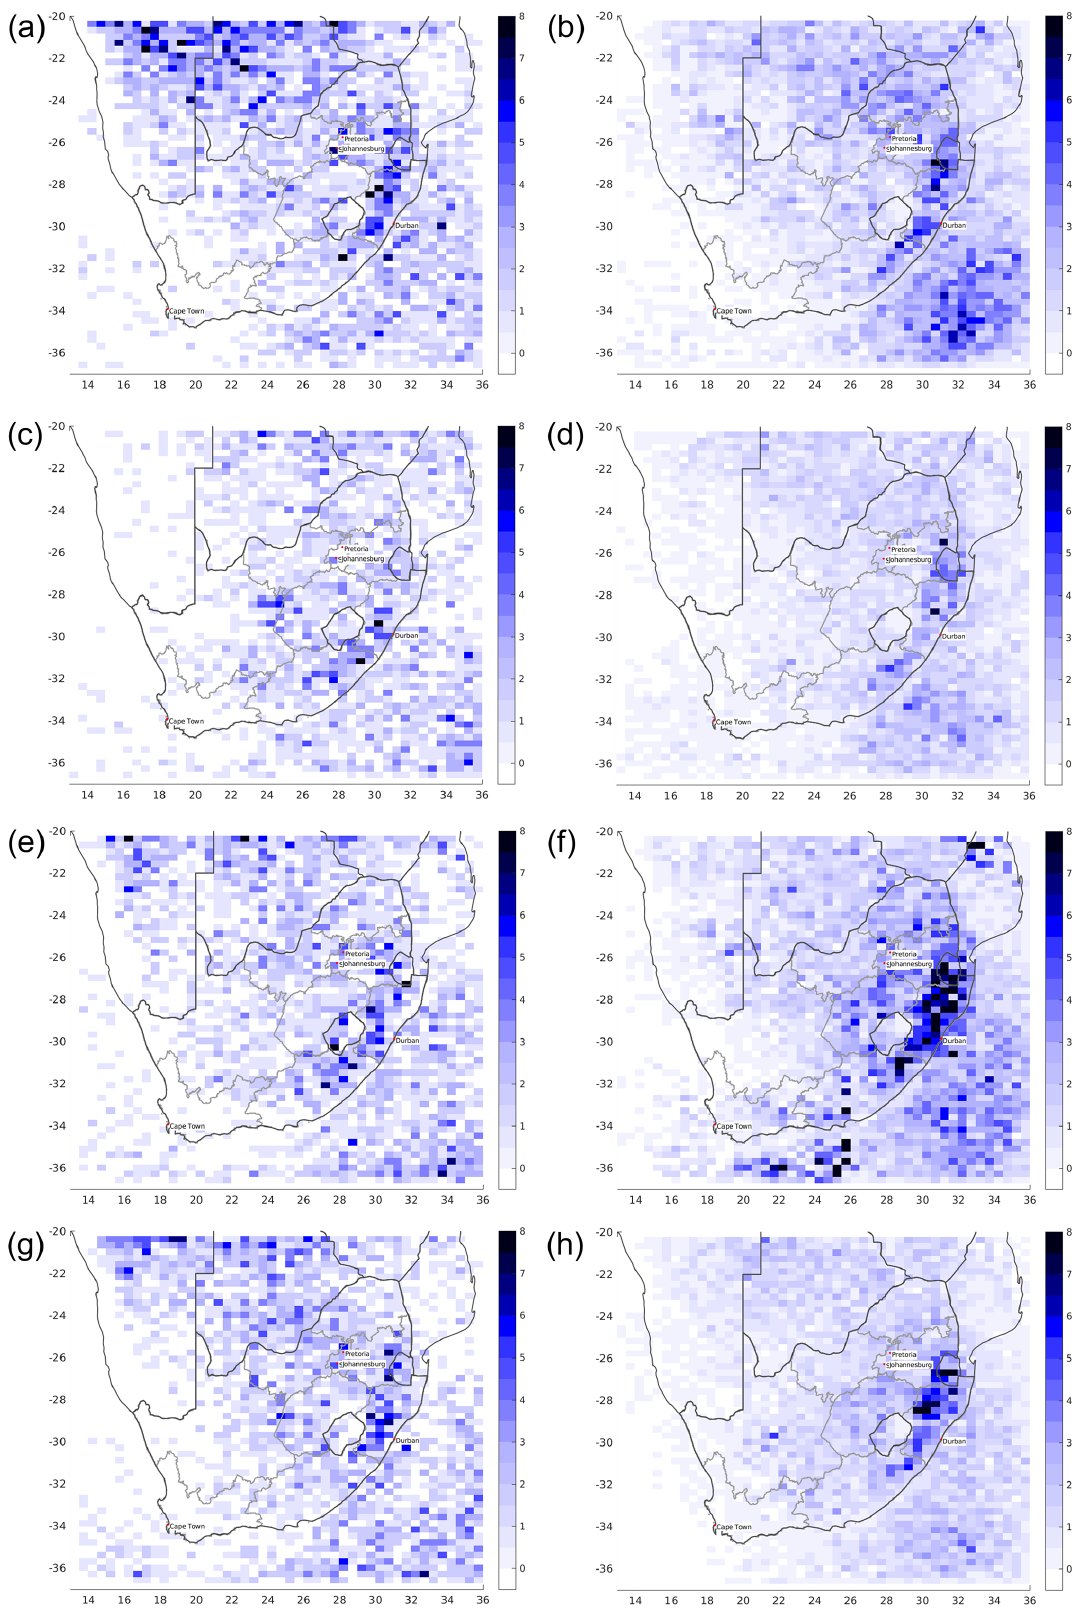
Figure 14. Spatial patterns of annual event distribution for single years (a, c, e, g) and the stochastic event set (b, d, f, h) for the years (a, b) 2005/2006, (c, d) 2006/2007, (e, f) 2007/2008, and (g, h) 2008/2009.